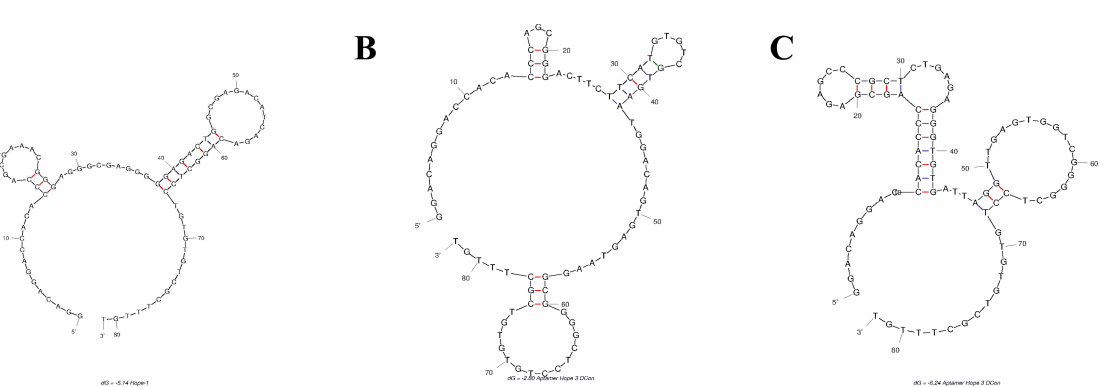
Figure 3. Predicted 2D Structure of anti-NELL1 Aptamer Candidates. The 2D structure of the aptamer candidates was predicted from the sequencing data and the ssDNA folding function of mFold web server. Figures show the three candidates with highest potential binding affinity: ( A ) AptNCan1, ( B ) AptNCan2, and ( C )